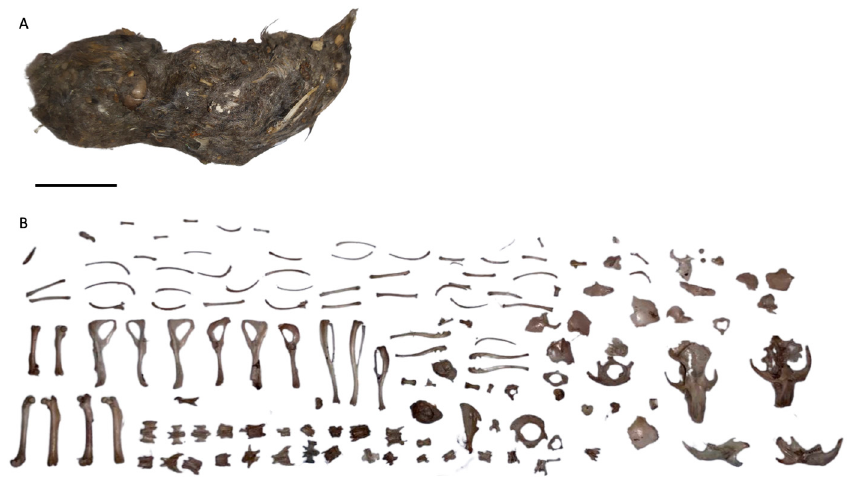
Figure 1. ( A ) Entire Long-eared owl pellet sampled under the Montefalco roost; ( B ) bones of at least two prey items retrieved from pellets (scale bar is 2 cm).